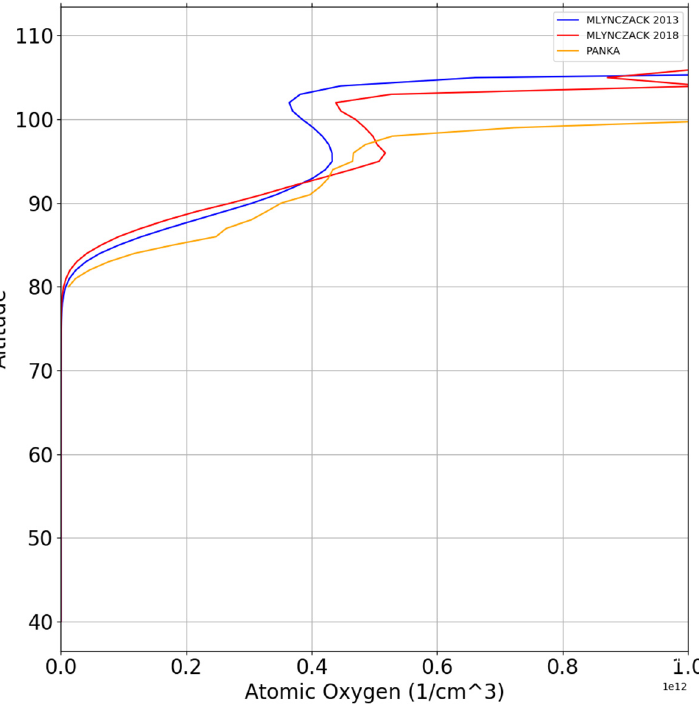
Figure 4. Vertical profiles of atomic oxygen concentration [ cm − 3 ] . Blue line is based on data calculated using [20], red line is calculated using [24] and yellow line is based on data from [25].